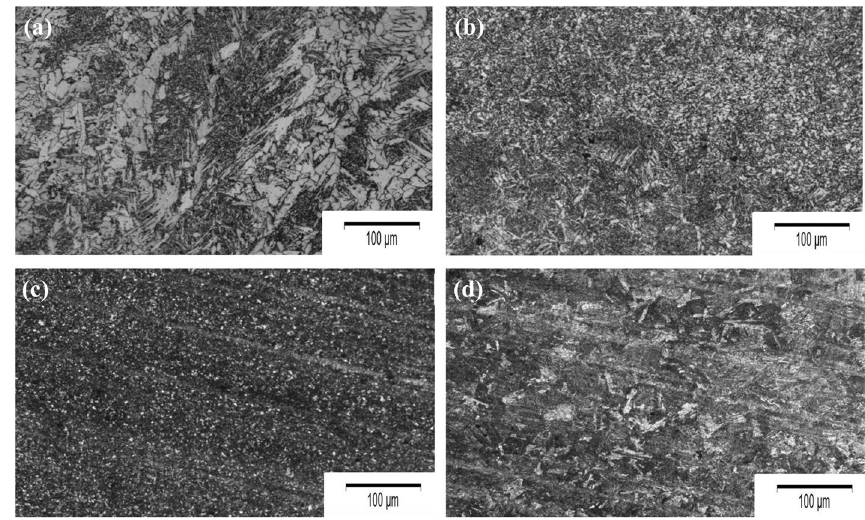
Fig. 20 Microstructure of single V welded joint using AWS A 5.18 ER70S-6 filler metal. a Weld metal. b The cellular structure with a bainitic structure in weld metal. c Over-tempering (softening zone) in HAZ zone. d Martensite structure in HAZ zone